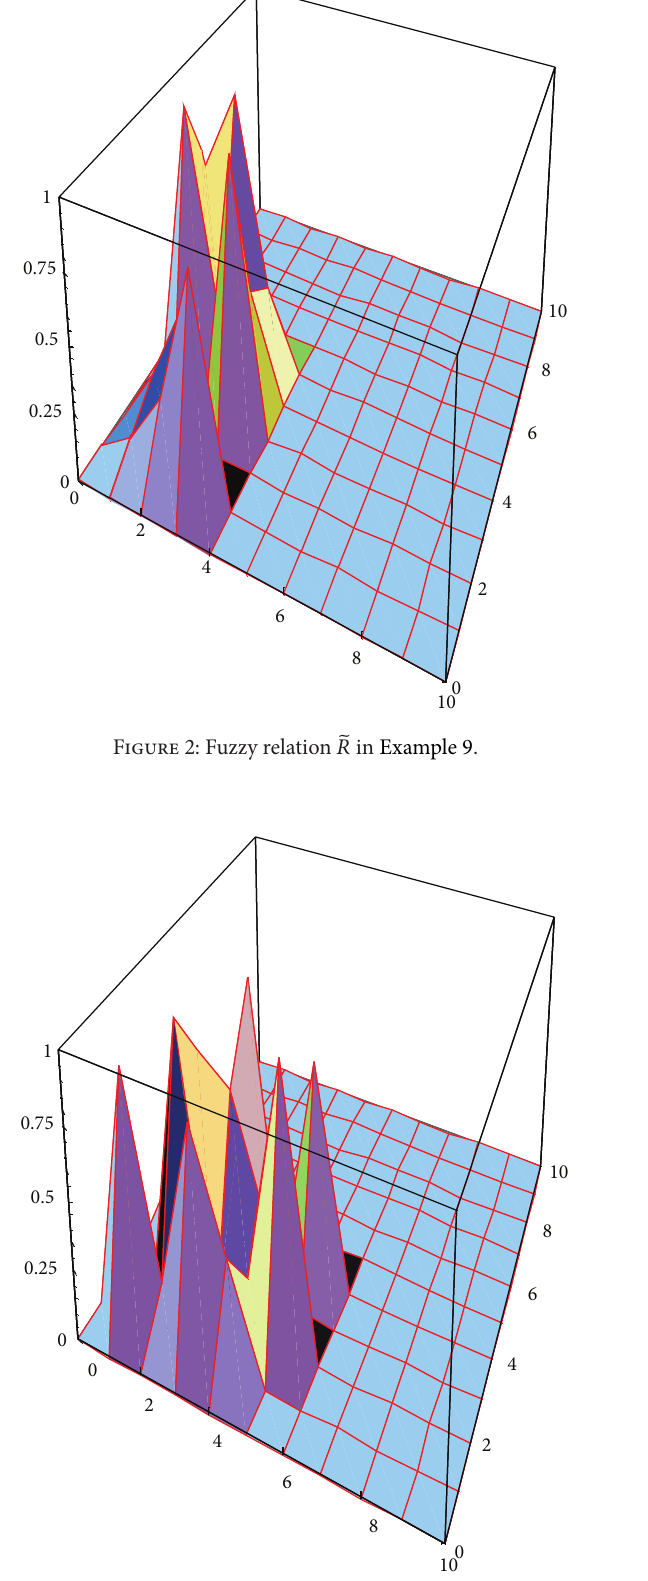
Figure 5: The max-product composition of fuzzy relations